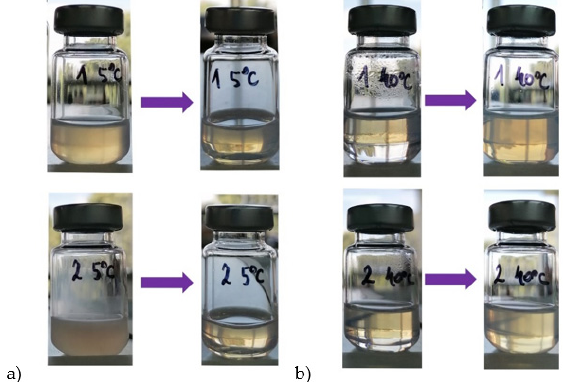
Figure 2. Visual appearance of nanoemulsions prepared with polyglycerol ester-based mixture without red raspberry oil on the left (sample 1—F0 PG NE) or with red raspberry oil on the right (sample 2—F1 PG NE) after one month of storage: ( a ) at 5 °C (cloudy samples), ( b ) at 40 °C (2-phase samples). All samples became clear/semi-transparent after one hour at room temperature (RT).